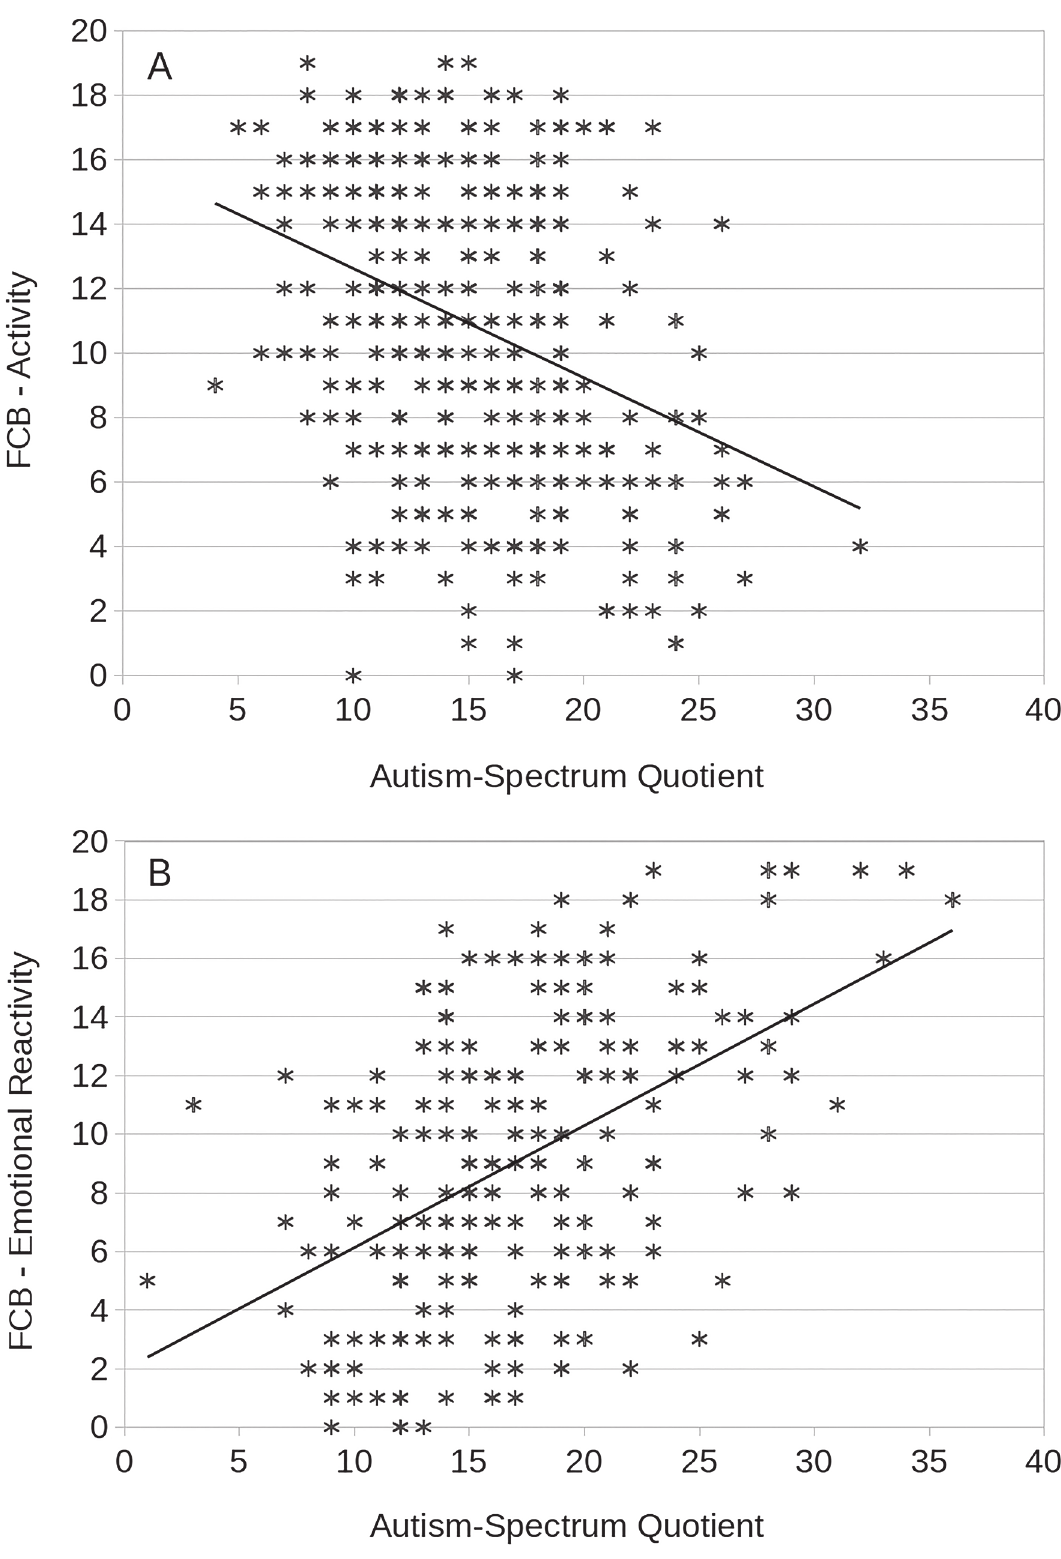
Fig 2. The correlation plots shown for the strongest coefficient values in group of A — females, B-males.